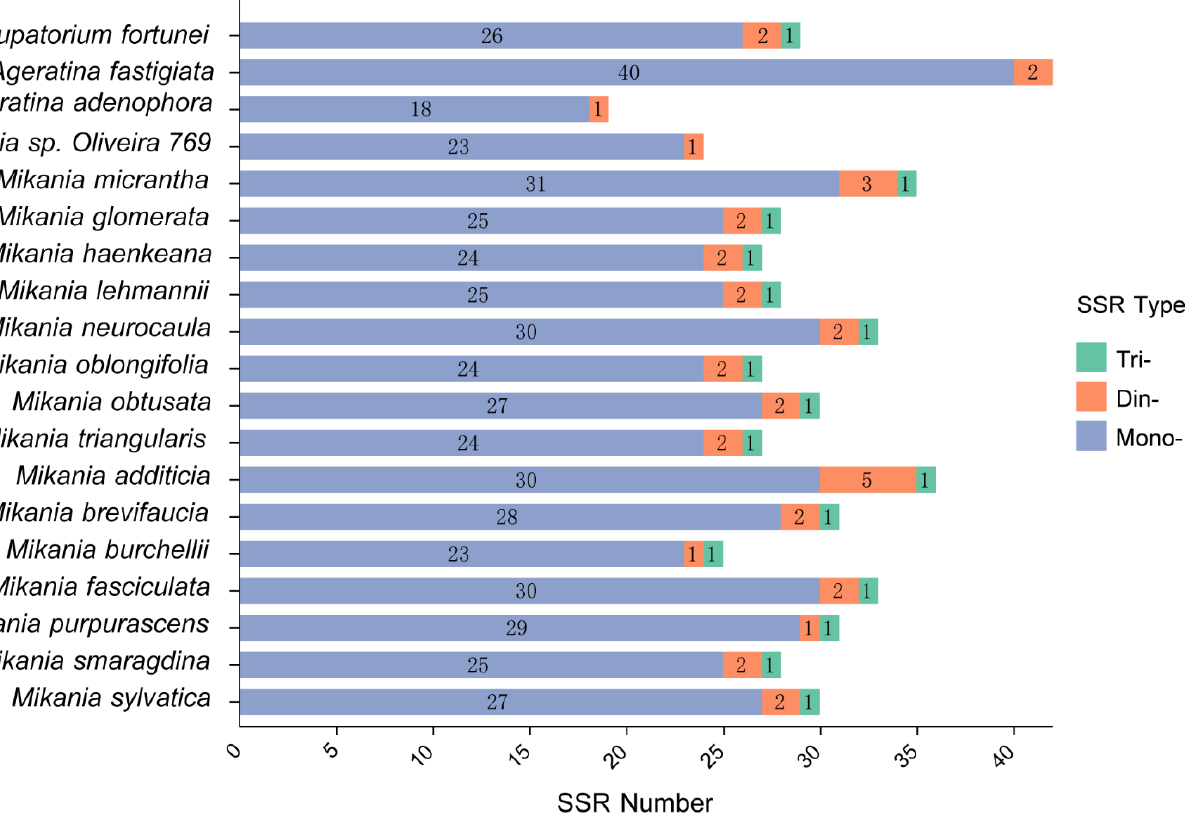
Figure 3. Distribution of SSRs in various regions of 19 Eupatorieae species. The x -axis represents the 20 Eupatorieae species and the position of each SSR in the chloroplast genome. The y -axis represents the number of SSRs in each chloroplast genome. Mono-, mononucleotide repeat; Di-, dinucleotide repeat; Tri-, trinucleotide repeat; Tetra-, tetranucleotide repeat.